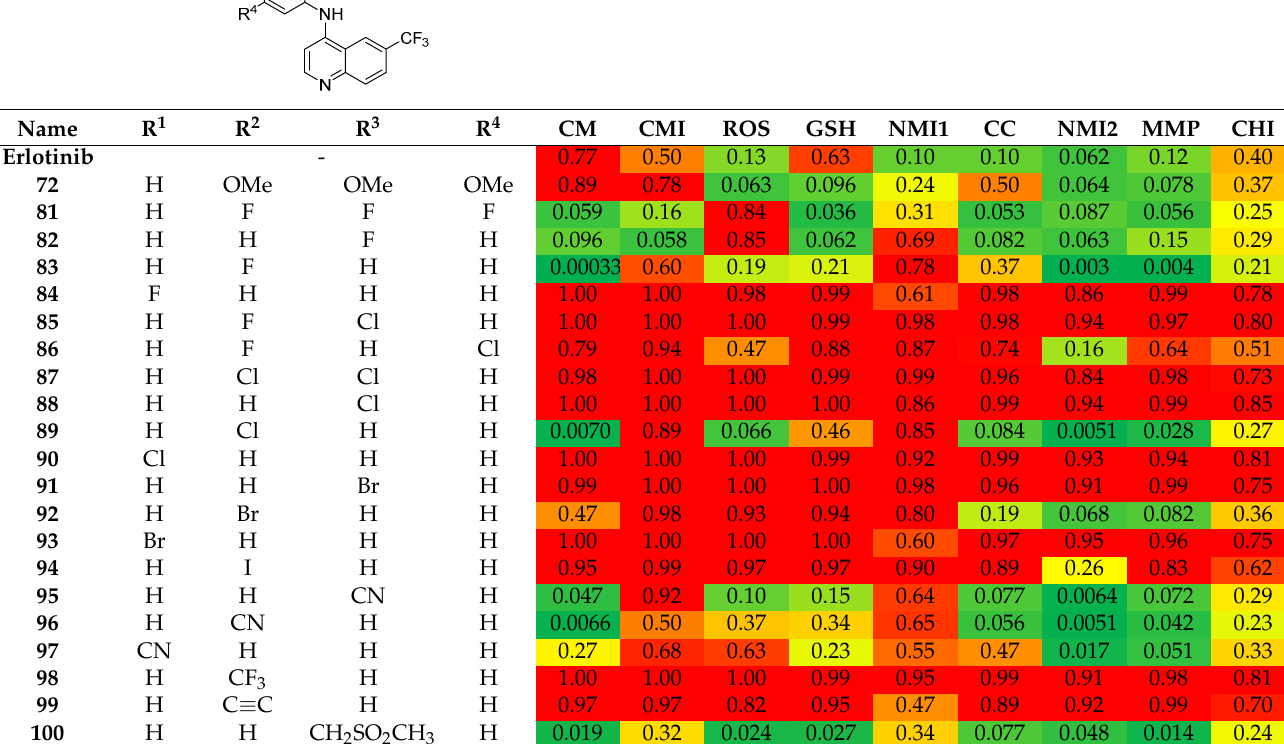
Table 7. Toxicity profiling of different aniline substitutions of 4-anilinoquinolines ( 81 – 100 ) based on the scaffold of analog 72 a,b,c .